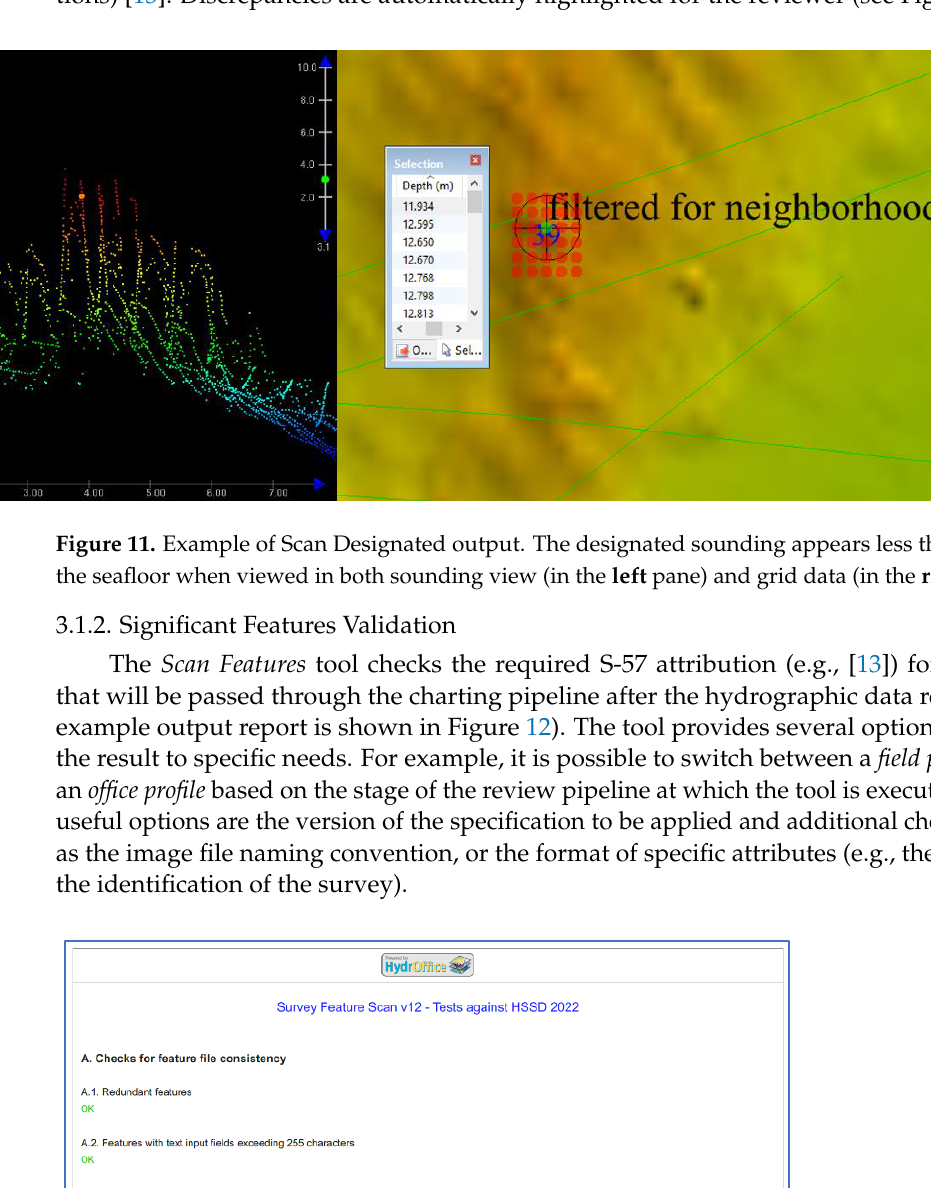
Figure 10. Extract from a PDF report generated by the BAG Checks tool. The report indicates which checks were performed and the results of the checks (passed checks in green, warnings in orange). the surface.